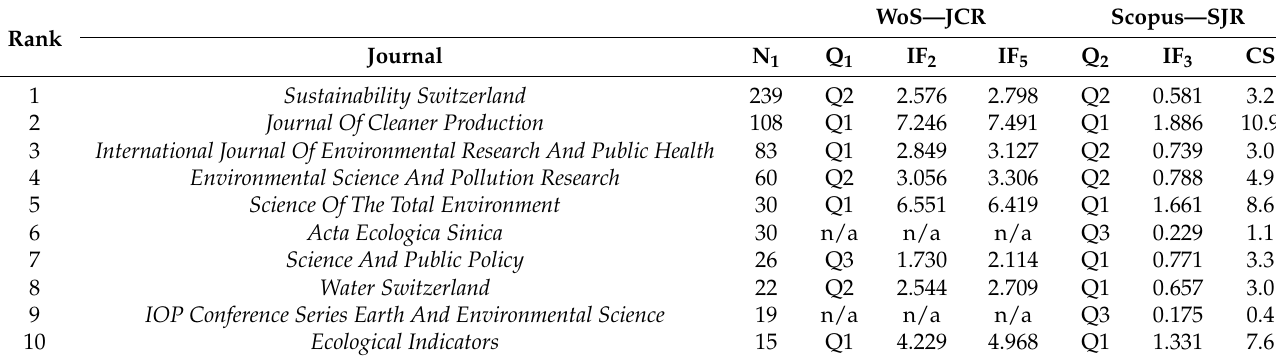
Table 16. Top 10 journals publishing articles on bibliometrics in the category of environmental sciences and their main bibliometric source indices.